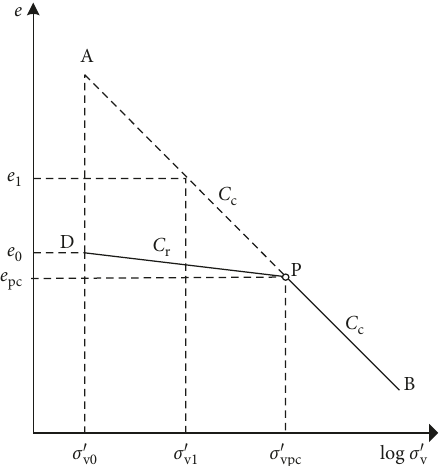
Figure 2: The relationship between e and σ